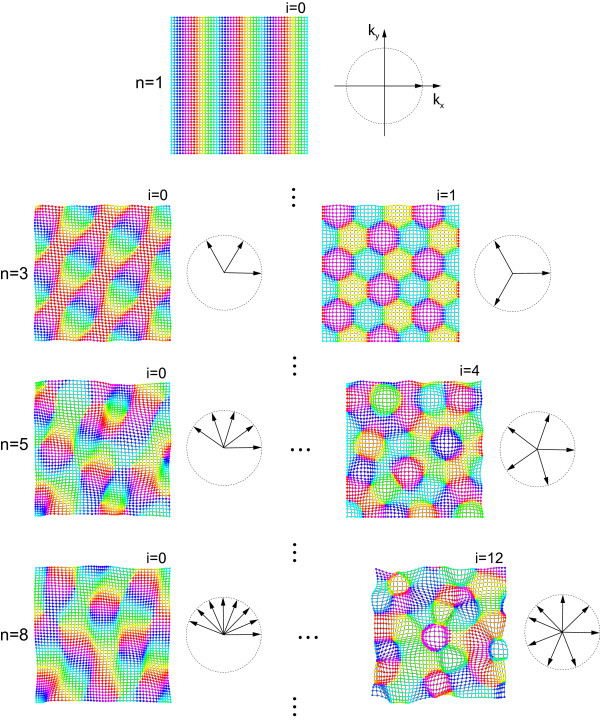
Coupled n-ECPs as dimension-reducing solutions of the EN model. Coupled n-ECP are displayed in visual space showing simultaneously the distortion of the RM and the OPM (σ/Λ = 0.3 (η = 0.028), ηr = η, circular stimulus ensemble). The distorted grid represents a the cortical square array of cells. Each grid intersection is at the receptive field center of the corresponding cell. Preferred stimulus orientations are color-coded as in Figure 2a. As in Figure 4, n and i enumerate the number of nonzero wave vectors and nonequivalent configurations of wave vectors with the same n, respectively. The coupled 1-ECP is a pinwheel-free stripe pattern without retinotopic distortion. Only the most anisotropic and the most isotropic coupled n-ECPs are shown for each n. Note that for all ECPs, high gradients within the orientation mapping coincide with low gradients of the retinotopic mapping and vice versa. Retinotopic distortions are displayed on a fivefold magnified scale for visualization purposes.